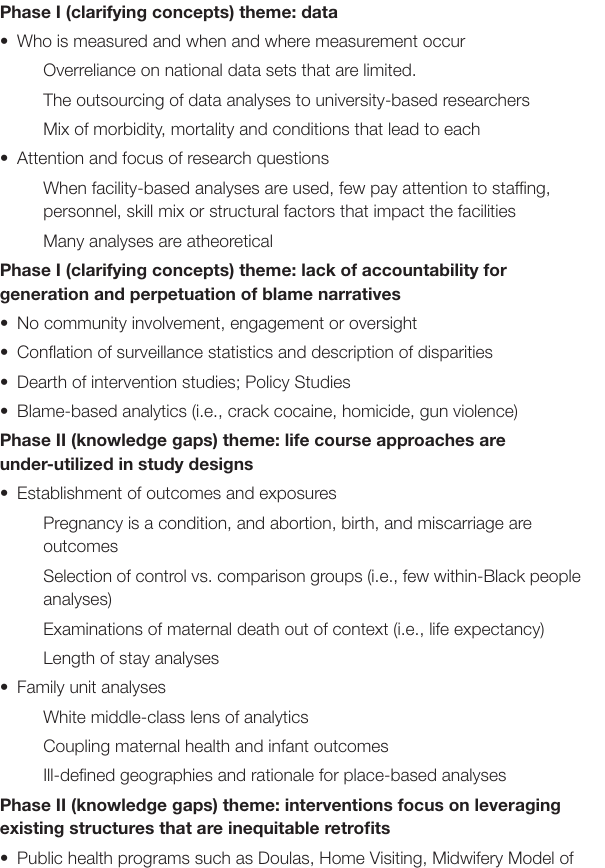
TABLE 1 | Thematic analysis of scoping review by phase. Phase I (clarifying concepts) theme: